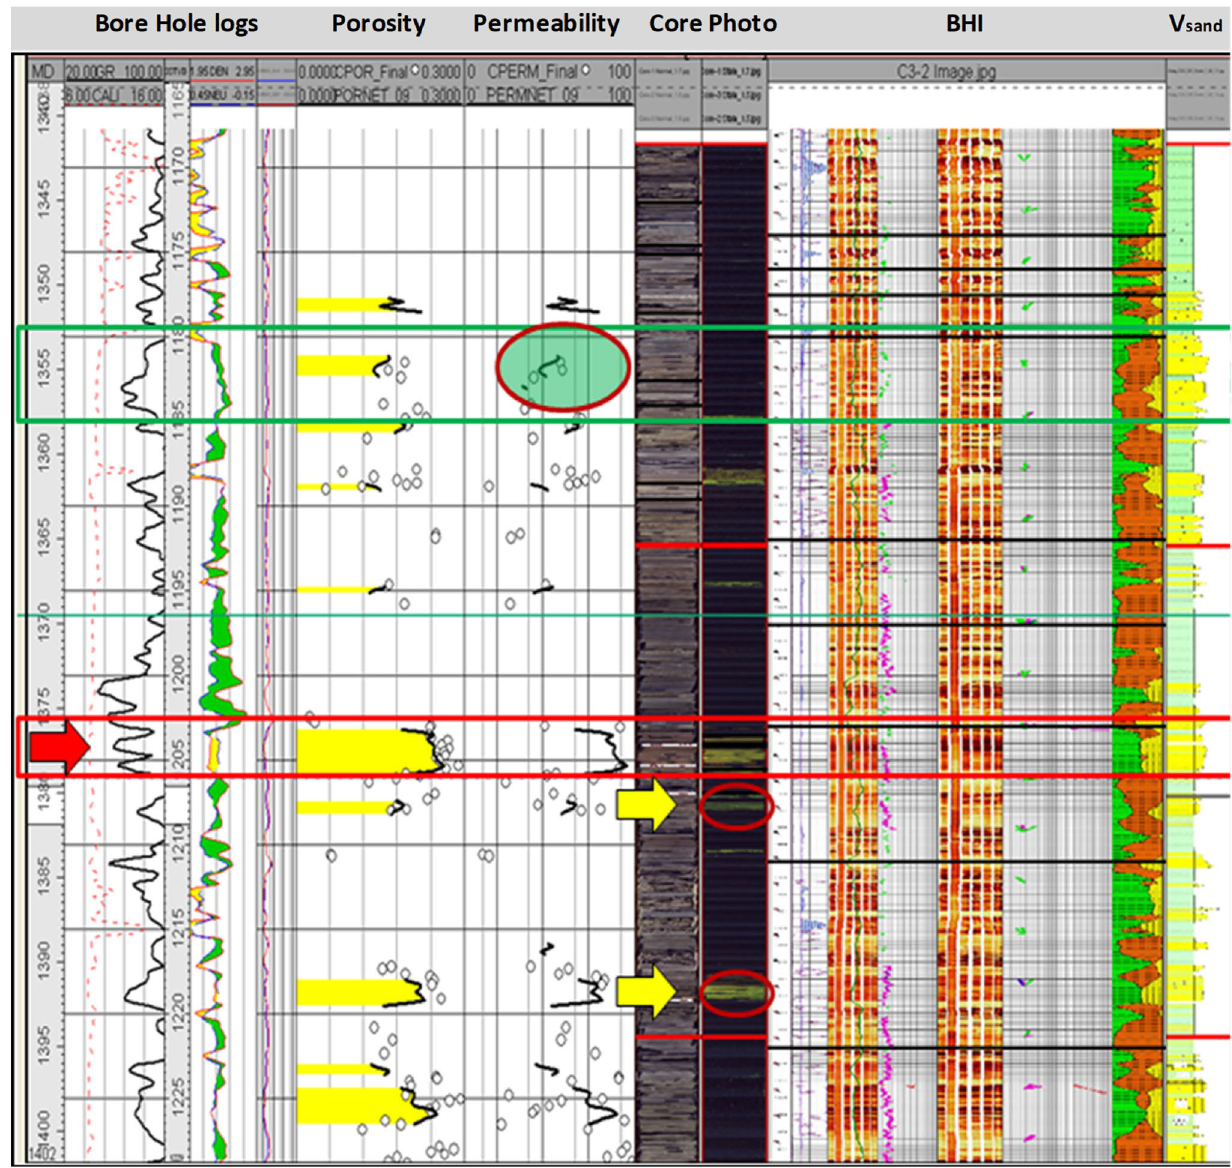
Fig. 6 Well-1 integrated plot for well logs, core analysis, core photographs, borehole Image and lithology modified from ElBelisy et al.